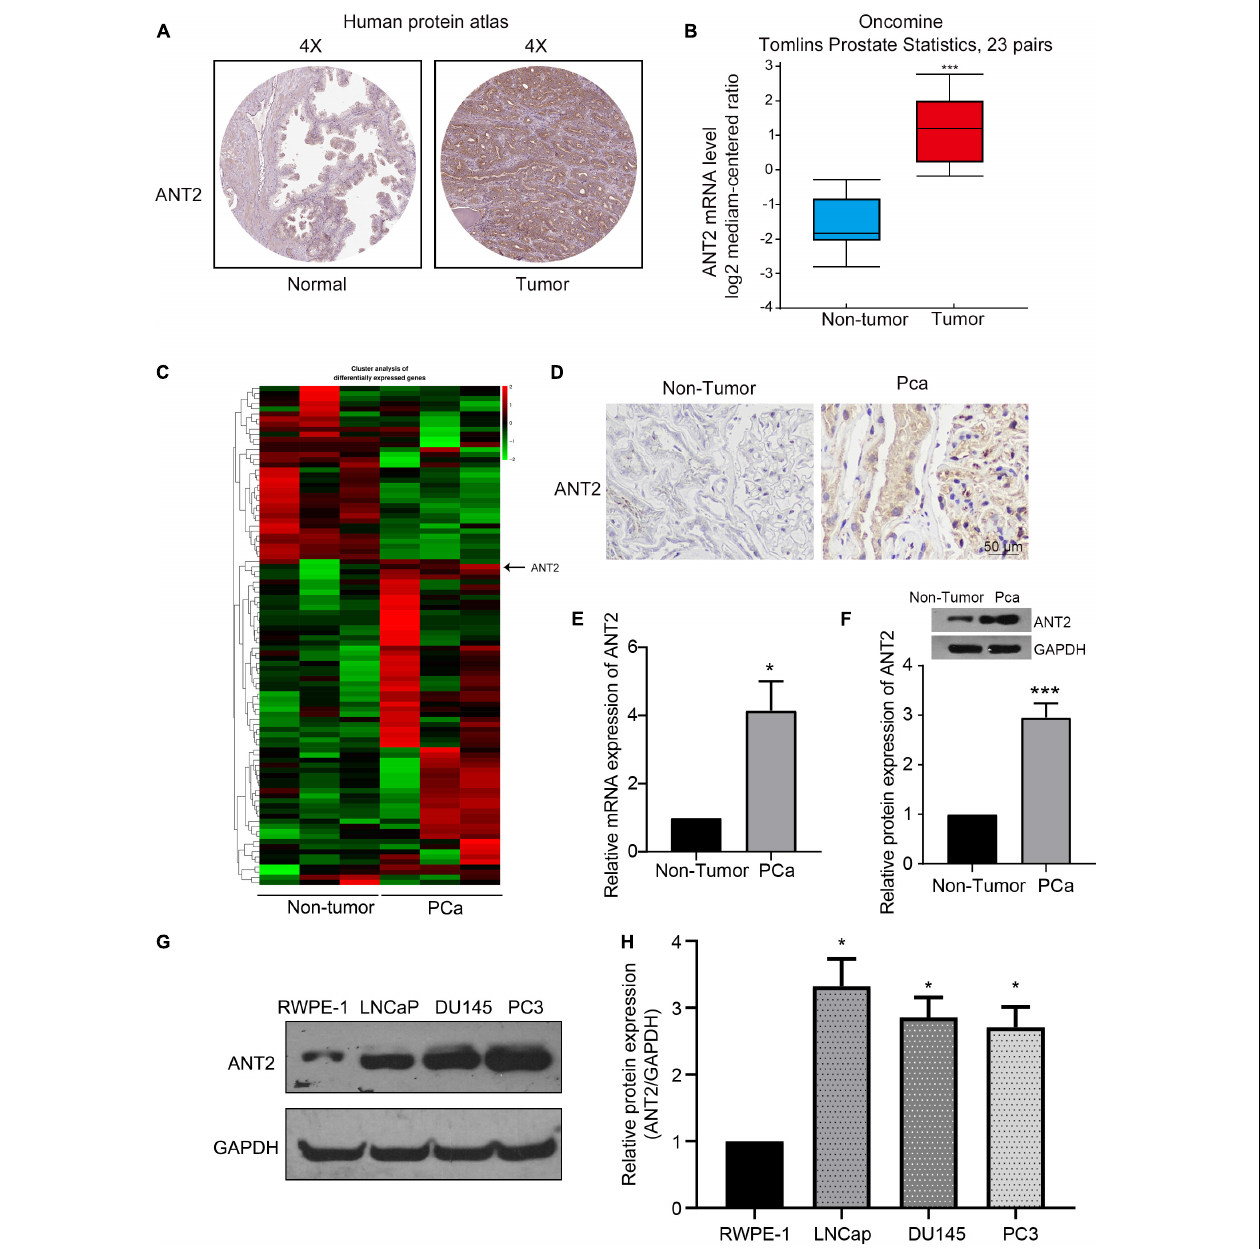
FIGURE 1 | Expression of ANT2 in prostate cancer tissues. (A,B) By searching the Human Protein Atlas and Oncomine databases, we found that the expression of ANT2 is low in normal prostate tissues and high in prostate cancer tissues: specifically, the level of ANT2 mRNA in prostate cancers was more than 3-fold higher than in normal prostate tissues. (C) A heatmap comparing normal tissue with prostate cancer tissue revealed higher expression of ANT2 in prostate cancer. (D) Immunohistochemical staining revealed higher expression of ANT2 in prostate cancer tissues. (E) qPCR revealed higher expression of ANT2 in prostate cancer tissues. (F) Western blotting confirmed higher expression of ANT2 in prostate cancer tissues. (G,H) The levels of ANT2 in prostate cancer cell lines LNCaP, DU145, and PC3 were higher than those in normal prostate cells, as determined by western blot assay. * p < 0.05; *** p <